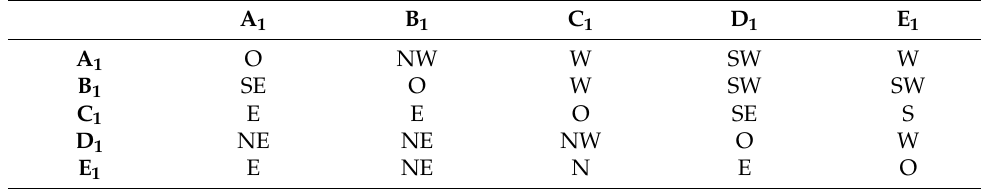
Table 11. Direction relations in the query scene (a) in Figure 17.